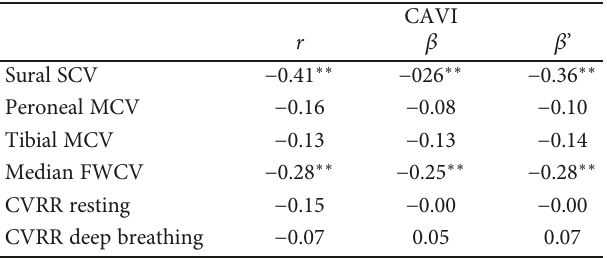
Coe ffi cients (standardized) of simple regression ( r ) and those of multiple regression ( β ) for the CAVI and ( β ’ ) for neuropathy indices are shown. Please see the main text for details of the other explanatory variables. ∗∗ p < 0 01 ; SCV: sensory nerve conduction velocity; MCV: motor nerve conduction velocity; FWCV: F-wave conduction velocity; CV R-R : coe ffi cient of variation of the R-R interval.